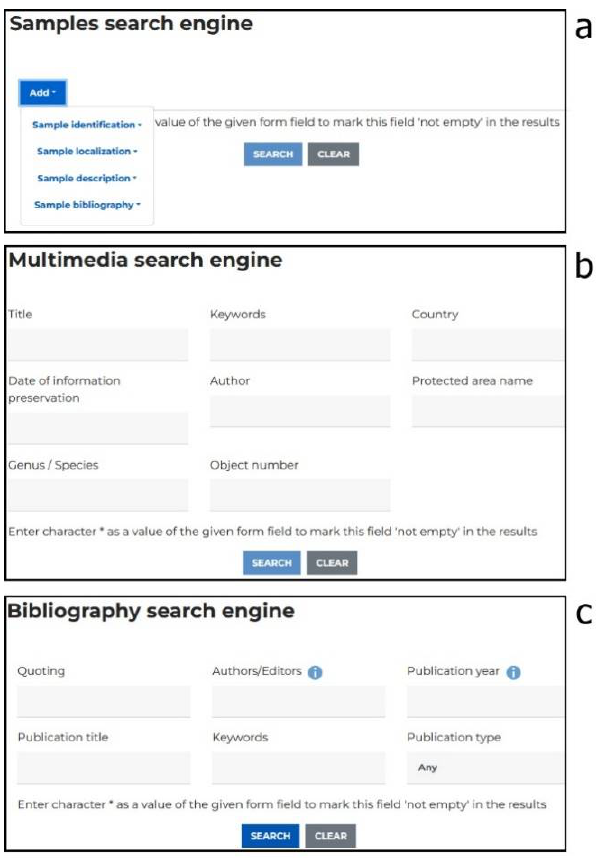
Figure 7. View of the search engines for taxonomically unidentified samples ( a ), multimedia ( b ), and bibliography ( c ).